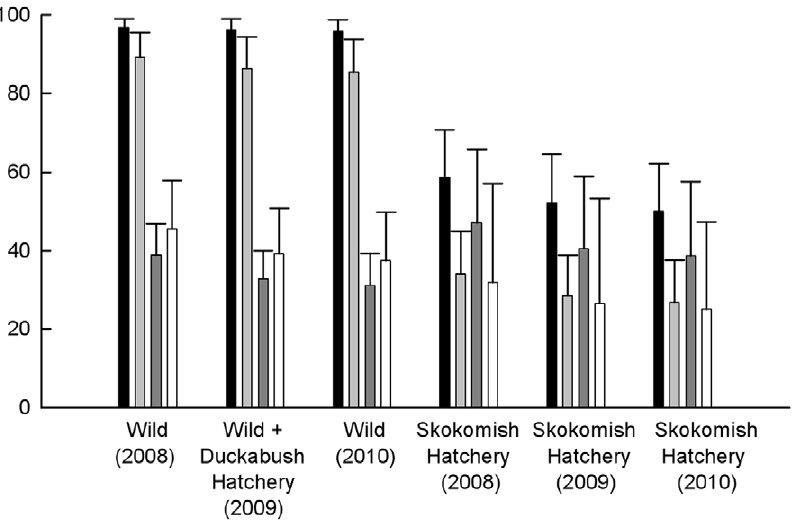
Figure 2. Survival estimates for smolts migrating through fresh- and saltwater migration segments. Survival probabilities ( 6 SE) are derived from the survival model with the lowest QAICc that included year ( w (segment 6 SkokH + year + rd), p (RM:line + rd), which grouped survival probabilities for the wild Big Beef and wild Skokomish smolt groups and the Duckabush hatchery group and estimated the Skokomish hatchery group separately. Black bars represent freshwater survival probabilities, light gray bars represent river mouth to Hood Canal Bridge (RM-HCB) survival probabilities, dark gray bars represent Hood Canal Bridge to Admiralty Inlet (HCB-ADM) survival probabilities, and white bars represent Admiratly Inlet to Strait of Juan de Fuca (ADM-JDF) survival probabilities for smolts migrating in 2008, 2009, and 2010. Error bars reflect variation among years within each smolt group.